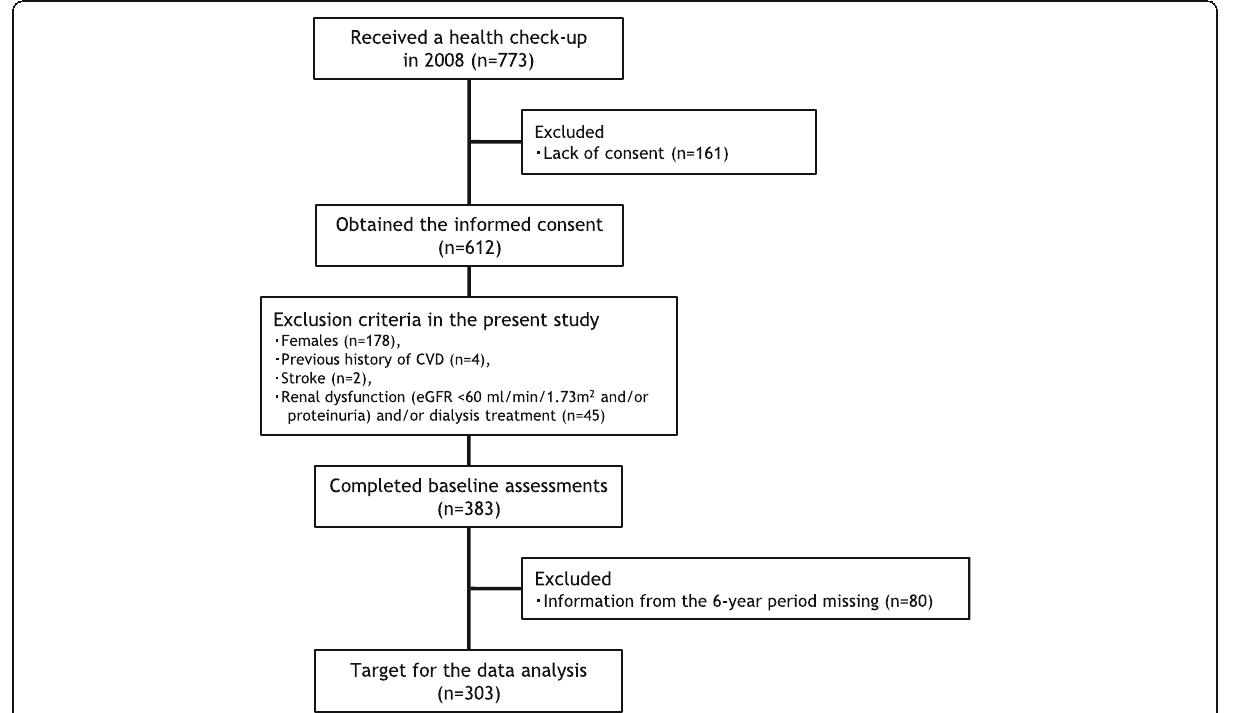
Fig. 1 A flow chart of the subjects included in the study. CVD cardiovascular disease, eGFR estimated glomerular filtration